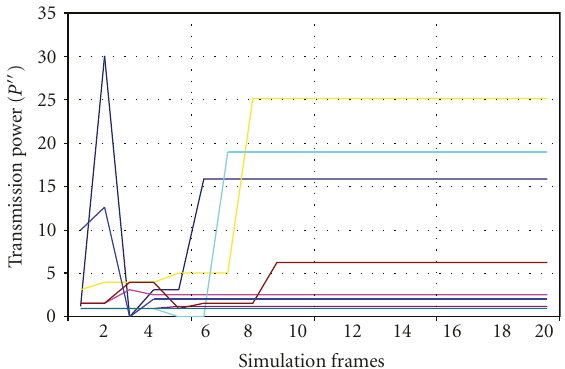
Figure 6: Convergence of SUs pairs –transmission power devoted to primary communication.